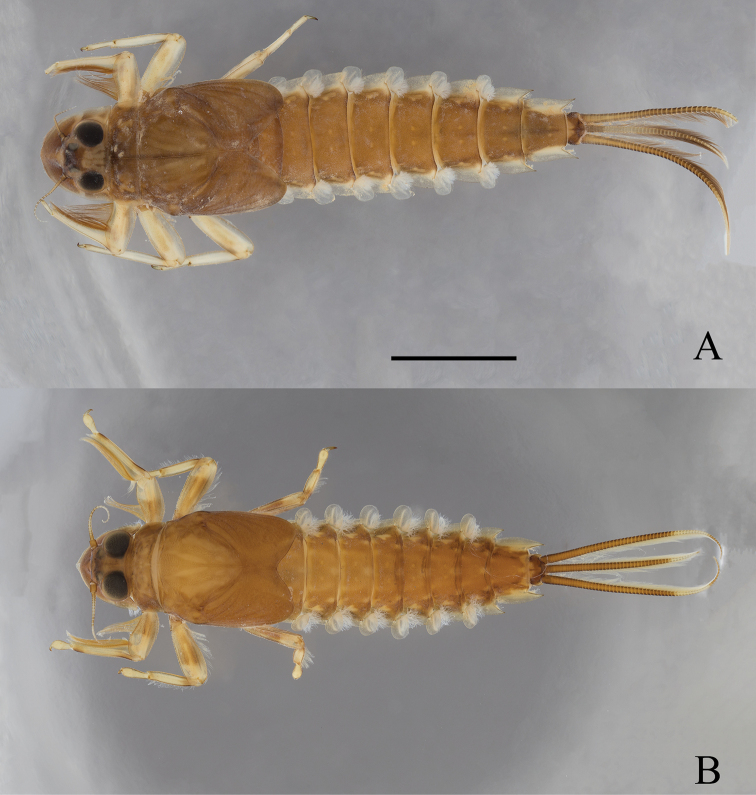
Habitus of Oligoneuriopsis nymphs in dorsal view AO.
skhounateBO.
orontensis. Scale bar: 5 mm.